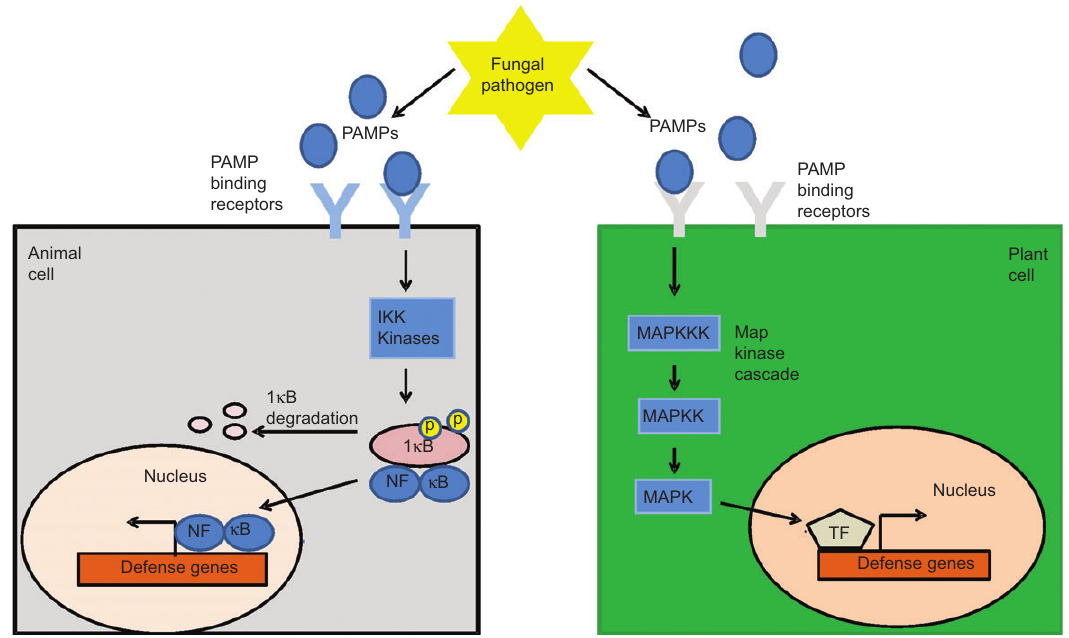
Figure 2 Model of the PAMP signaling pathway. Fungal pathogens release PAMPs, which bind to plant membrane-associated PRRs. The binding of PAMP leads to activation of the MAPK cascade ultimately activating transcription factors (TFs), which mediate the expression of defense-related genes. PAMPs can also bind to animal cell receptors, which lead to activation of pathways such as the NF- κ B pathway. PAMP binding to receptors involved in this pathway activates the IKK kinase. This kinase cascade results in the phosphorylation and subsequent ubiquination of I κ B, allowing the release of the TFs, NF, and κ B. The TFs are then translocated to the nuclease and regulate the transcription of defense response